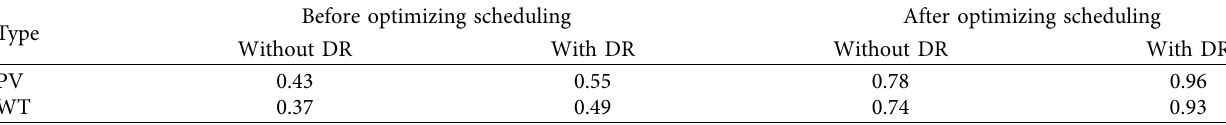
Table 6: Comparison of wind and solar consumption rate.